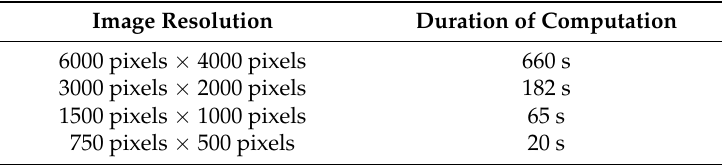
Table 2. Computational